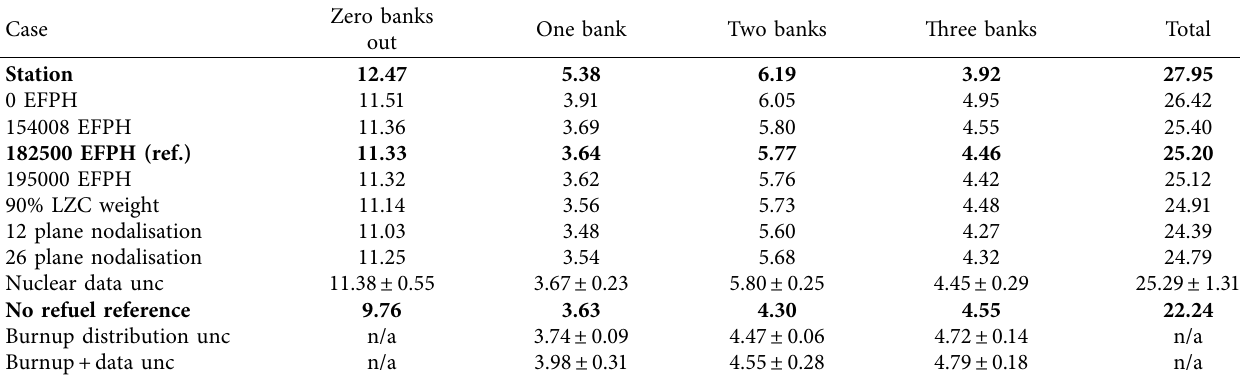
Table 4: Comparison of station data and simulations on shim transient timings (in days). Uncertainties are stated as one standard deviation. Case